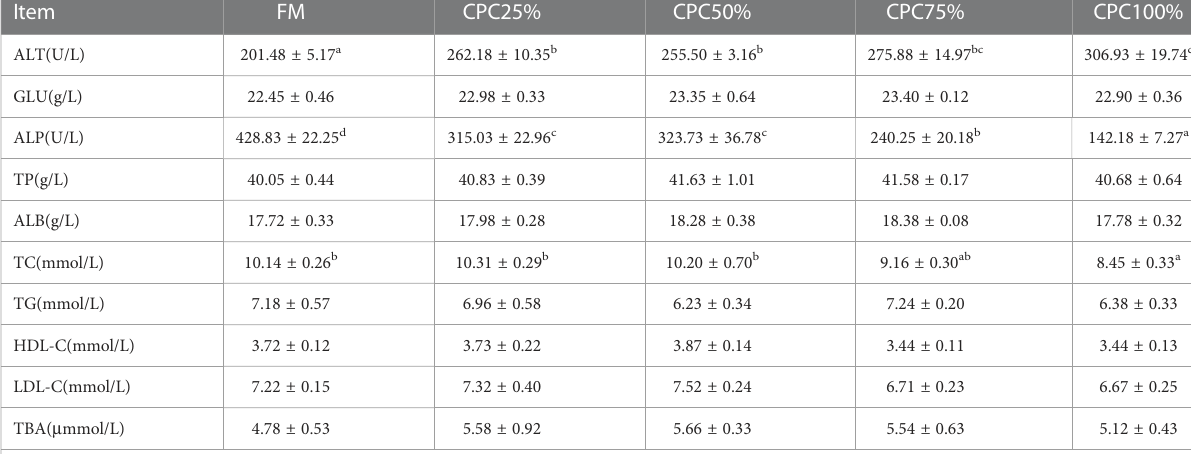
TP, total protein; ALB, albumin; TC, total cholesterol; HDL-C, high density lipoprotein cholesterol; LDL-C, low density lipoprotein cholesterol; TG, triglyceride; TBA, total bile acid; GLU, glucose; ALT, alanine aminotransferase; ALP, alkaline phosphatase; Values with different superscripts in the same column are signi fi cantly different (P<0.05).